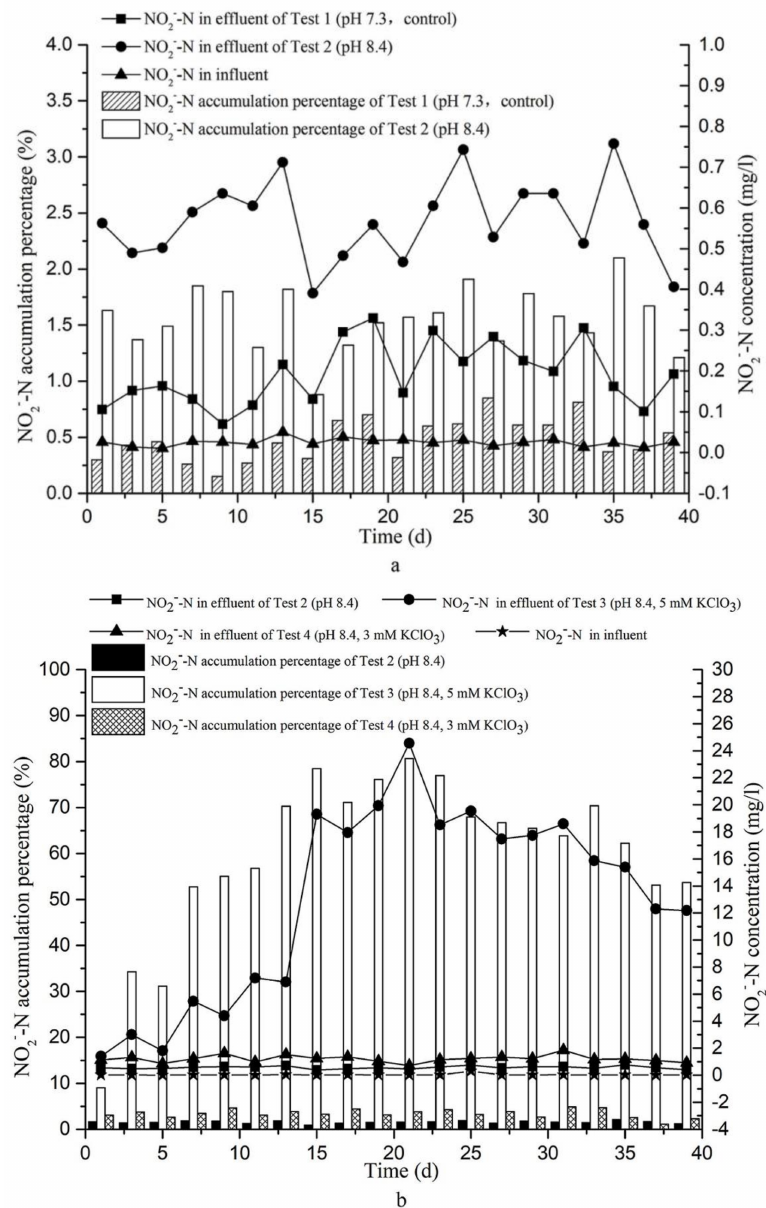
Figure 7. Nitrite accumulation in effluent. ( a ) Effect of pH on nitrite accumulation percentage (bars) and concentration (curves) in the effluent of Test 1 (pH, 7.3) and Test 2 (pH 8.4); ( b ) The nitrite accumulation percentage (bars) and concentration (curves) in effluent of Tests